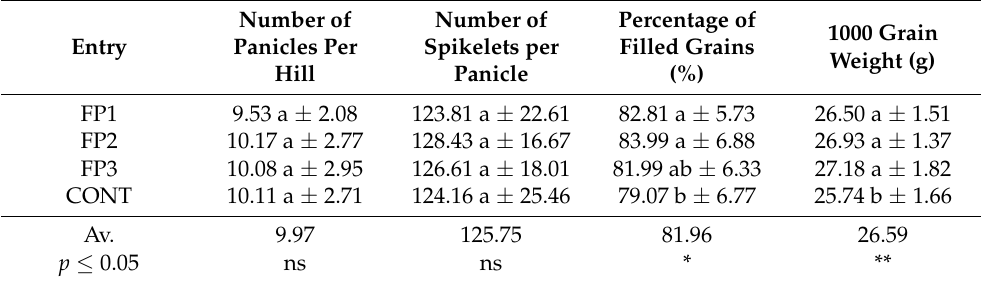
Table 5. Number of panicles, number of spikelets per panicle, percentage of filled grains, and 1000 grain weights of rice plants treated with different combinations of chemical fertilizer and plant-growth-promoting